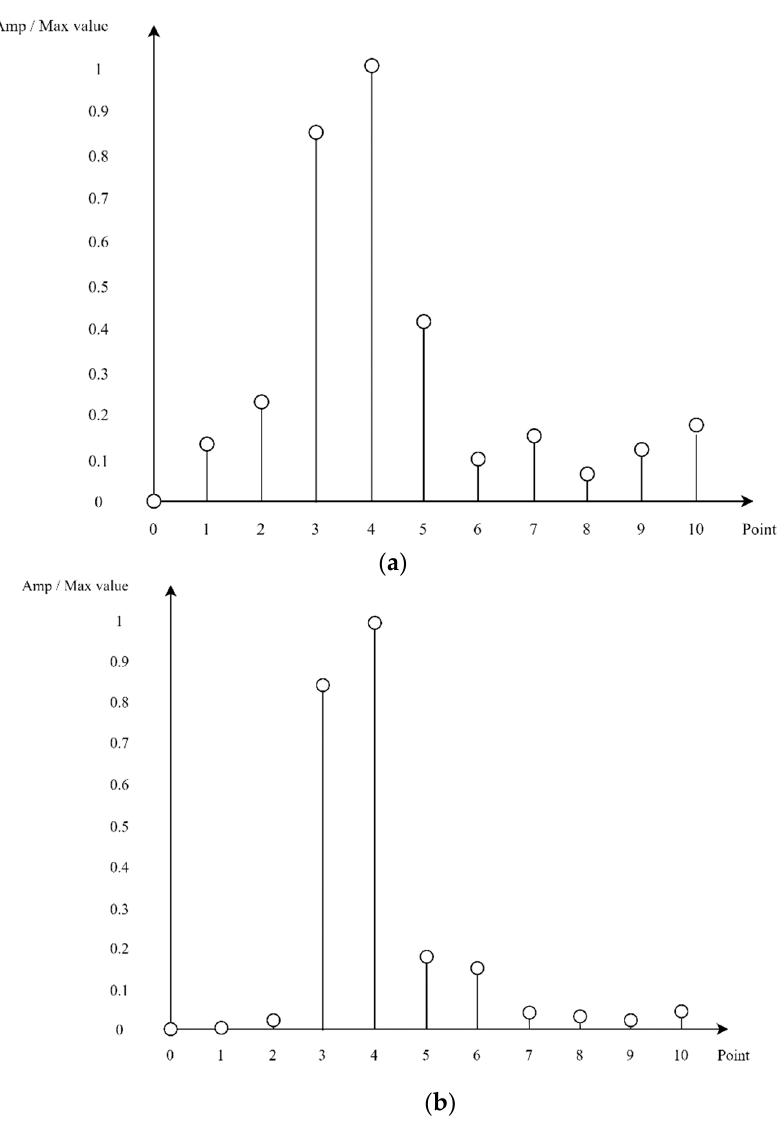
Figure 7. Frequency-domain signals for single target ( a ) and two targets ( b ). ( a ) Case of there is object at 3.5 m; ( b ) Case of there are objects at 3 and 4 m.